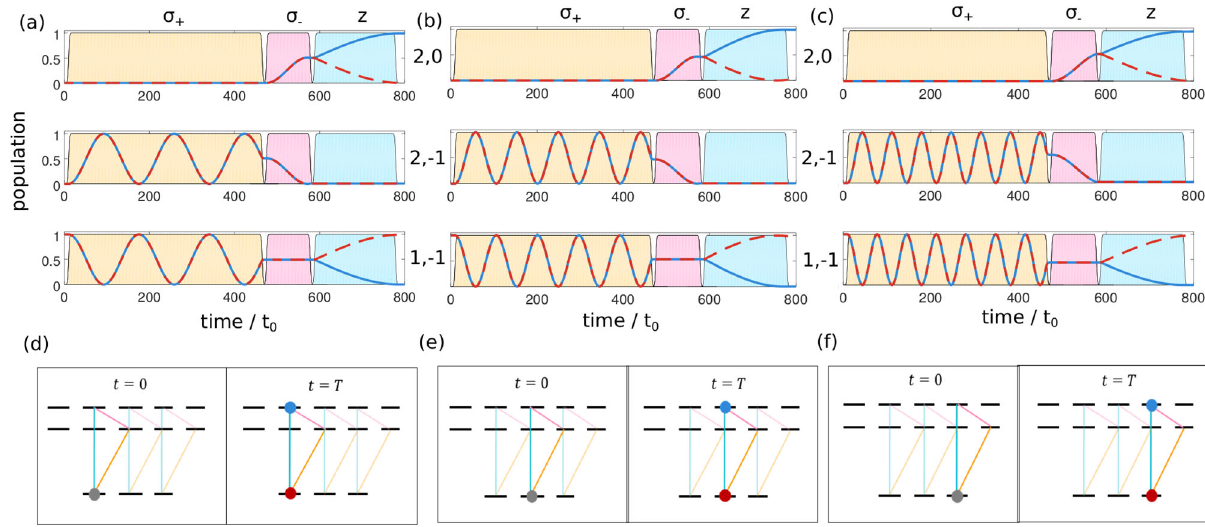
Fig. 6 Full control of enantiomer-selective state transfer, based on synchronized three-wave mixing. a , b , and c Depict the rotational dynamics for the initial states J , τ = 1, − 1 with M = − 1, M = 0, and M = 1, respectively, where J , τ , and M are the asymmetric top quantum numbers, showing the population in the levels J , τ = 2, 0, J , τ = 2, − 1 and J , τ = 1, − 1. The two enantiomers are denoted by solid blue and dashed red lines. The envelope of the pulses is indicated by the orange ( ω = ω 1 ), pink ( ω = ω 2 ), and turquoise ( ω = ω 3 ) shapes. The height of these shapes indicates the maximal electric fi eld strength (in arbitrary units) and the polarization is denoted by σ + , σ − and z . Time is given in units of t 0 = ℏ / B , where B is a rotational constant. The initial ( t = 0) and fi nal ( t = T ) states are sketched in d , e , and f . The gray circles indicate which states are initially populated by both enantiomers, the blue (red) circles show which states are fi nally populated by enantiomer 1 (enantiomer 2). The transitions induced by the three fi elds are indicated by the orange, pink, and turquoise lines with the transition affecting the respective initial state highlighted. The frequencies ω 1 , ω 2 , and ω 3 for carvone are listed in Table